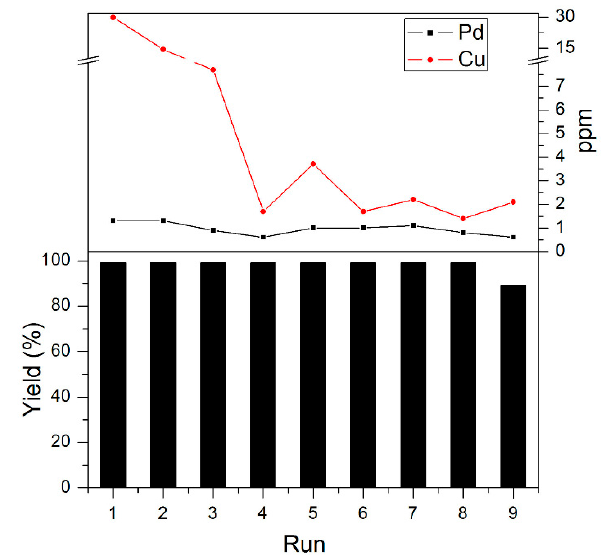
Figure 5. Recycling experiments using Pd / Cu@AC in the cross-coupling reaction between 4-iodotoluene and phenylacetylene, and the ICP-MS results of Pd / Cu leaching in the solution of 1–9 cycles. The yields were determined by 1H-NMR.